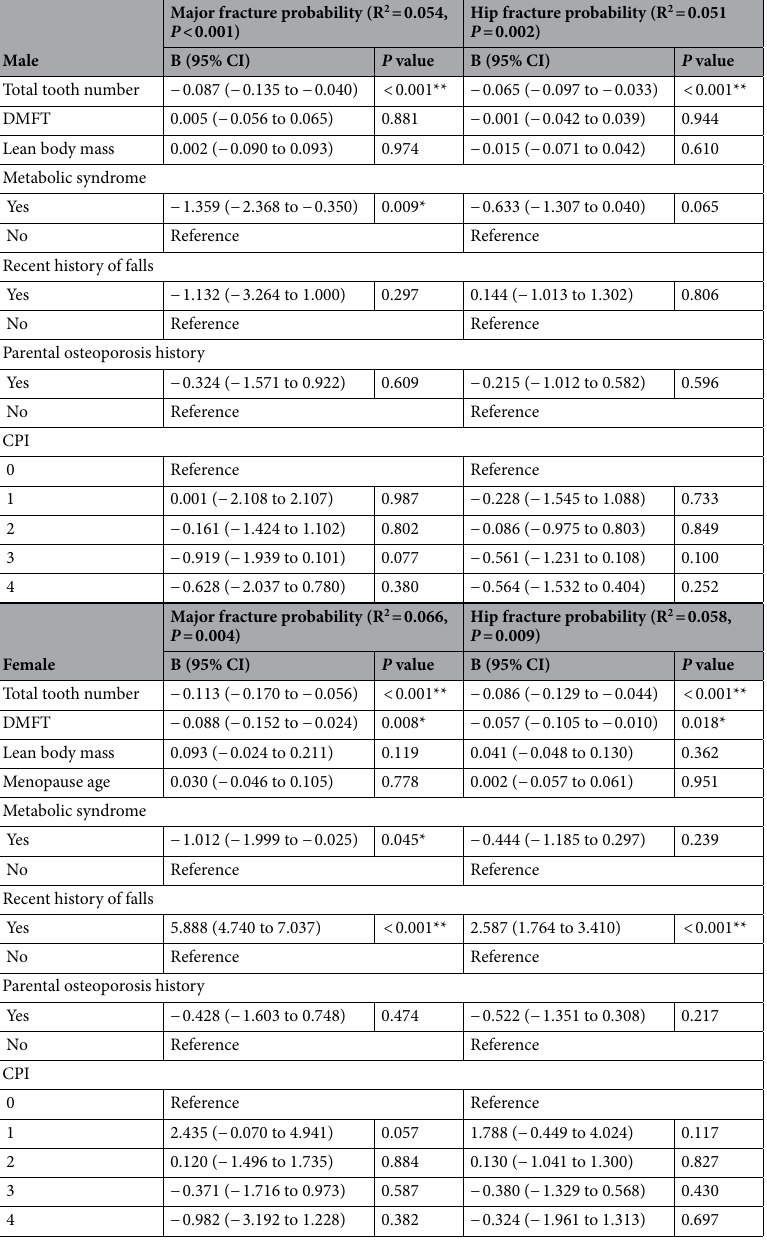
Table 3. Adjusted association between ten-year probability major fracture and hip fracture and oral health related factors. CI, confidential interval; CPI, community periodontal index; DMFT, decay, missing, filling tooth. Data obtained from the multivariate linear regression. *P < 0.05, ** P < 0.001 by the multivariate linear